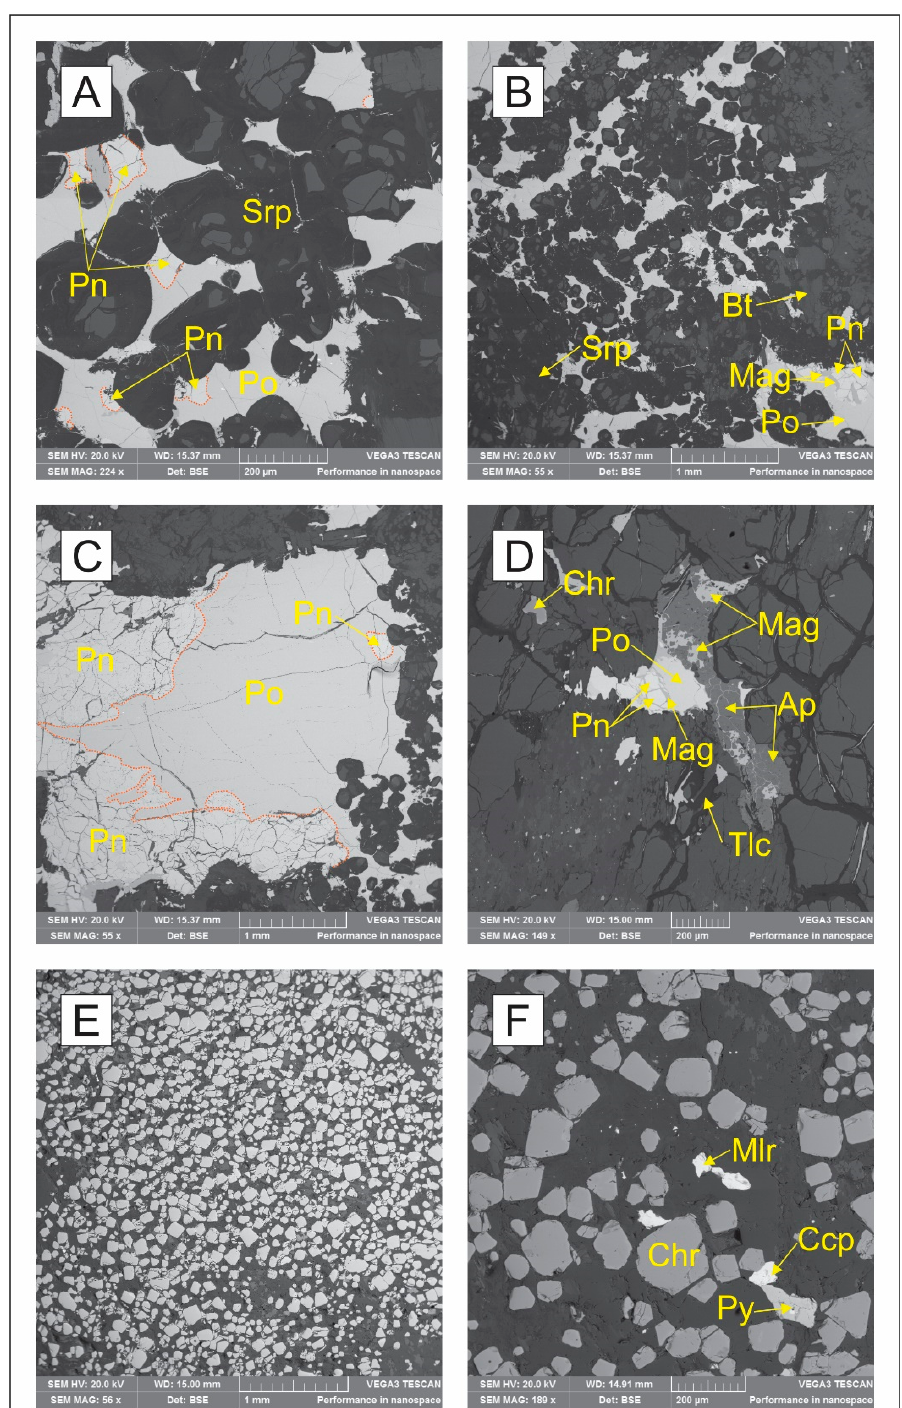
Figure 3. Backscattered electron photomicrographs showing some of the common textural properties of the ore types based on examination of thin sections. ( A ) Interstitial base-metal sulphide (BMS) characterized by secondary silicates replacing pyrrhotite. This texture was common in the high-grade Ni-Cu sulphide silicate ore containing disseminated chromite (PCMZ_HG) ore. ( B ) Interstitial BMS showing the pervasive alteration indicated by the formation of magnetite interstitially to pentlandite and pyrrhotite. ( C ) A core of pyrrhotite with coronas of pentlandite common in the medium-grade